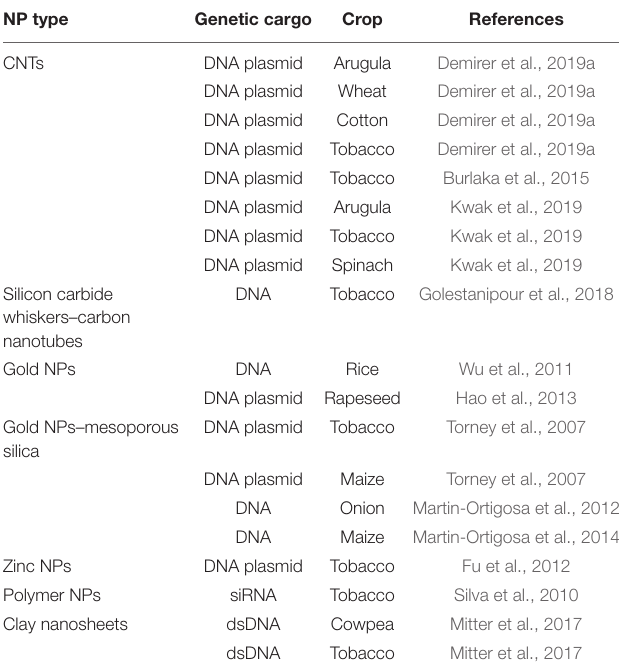
TABLE 2 | Nanoparticle (NP)-mediated transformation methods used for various